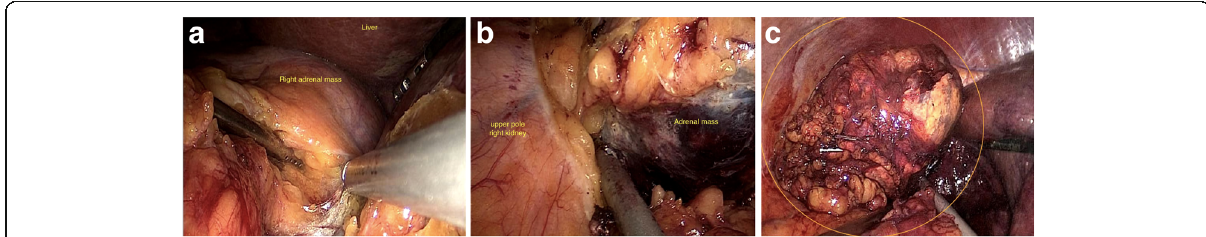
Fig. 4 a – c Resection of adrenal mass, encapsulated in a fibrotic tissue (marked with a circle in c ), with hemorrhagic areas, through an intraperitoneal laparoscopic right